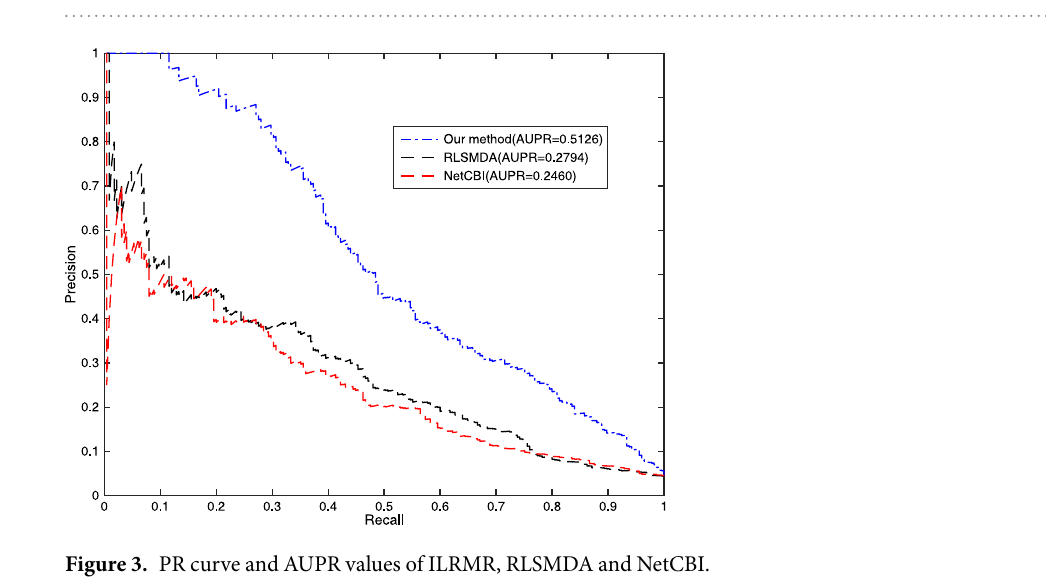
Figure 2. Comparison of methods between ILRMR, Net-CBI, and RLSMDA in terms of ROC curve and AUC on LOOCV. Without miRNA family and similarity of known miRNA-disease association network under consideration, ILRMR outperformed Net-CBI and RLSMDA in LOOCV.